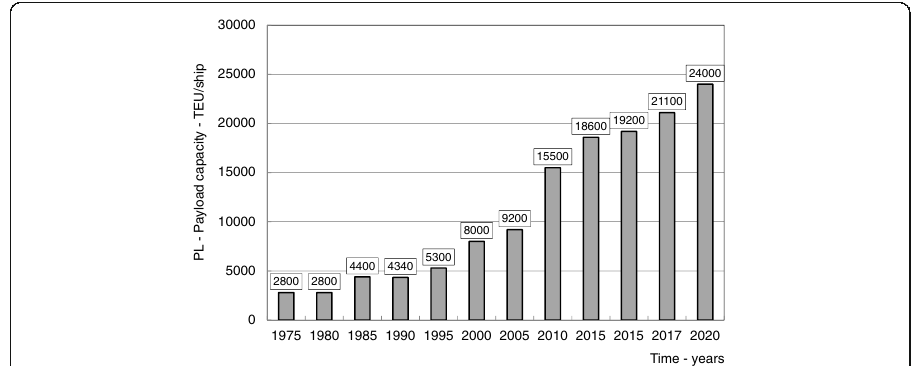
Fig. 2 Development of the payload capacity of the maritime container ships over time (Period: 1975 – 2016) (Rodrigue et al. 2017; ITF 2015; UNCTAD